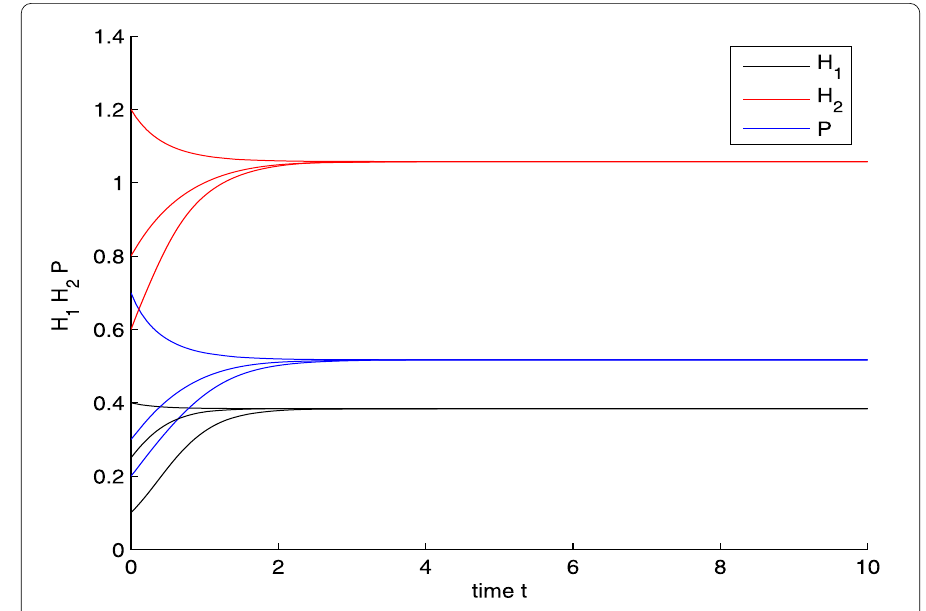
Figure 1 Dynamical behavior of system (5.1) with initial values (0.4,1.2,0.7) T , (0.1,0.8,0.2) T and (0.25,0.6,0.3)